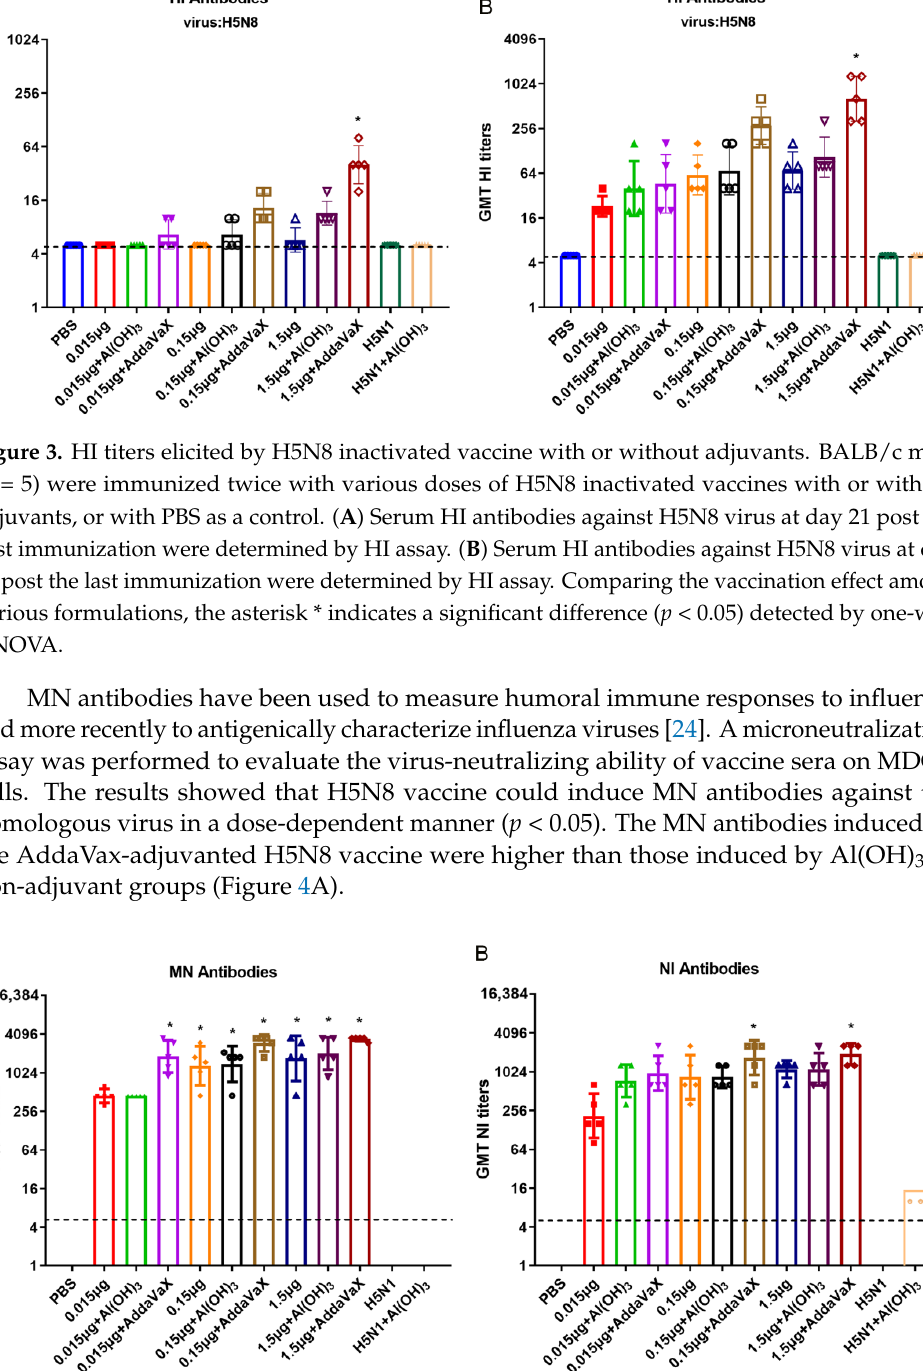
Figure 4. MN and NI titers elicited by H5N8 inactivated vaccine with or without adjuvants. BALB/c mice ( n = 5) were immunized twice with various doses of H5N8 inactivated vaccines with or without adjuvants. ( A ) The MN titers against H5N8 virus in serum were analyzed by MN assay at day 21 post the last immunization. ( B ) The NI titers against H5N8 virus in serum were analyzed by NI assay at day 21 post the last immunization. The H5N8 whole-virus inactivated vaccine acted as the source of antigen. Comparing the vaccination effect among various formulations, an asterisk * indicates a significant difference ( p < 0.05), by one-way ANOVA.